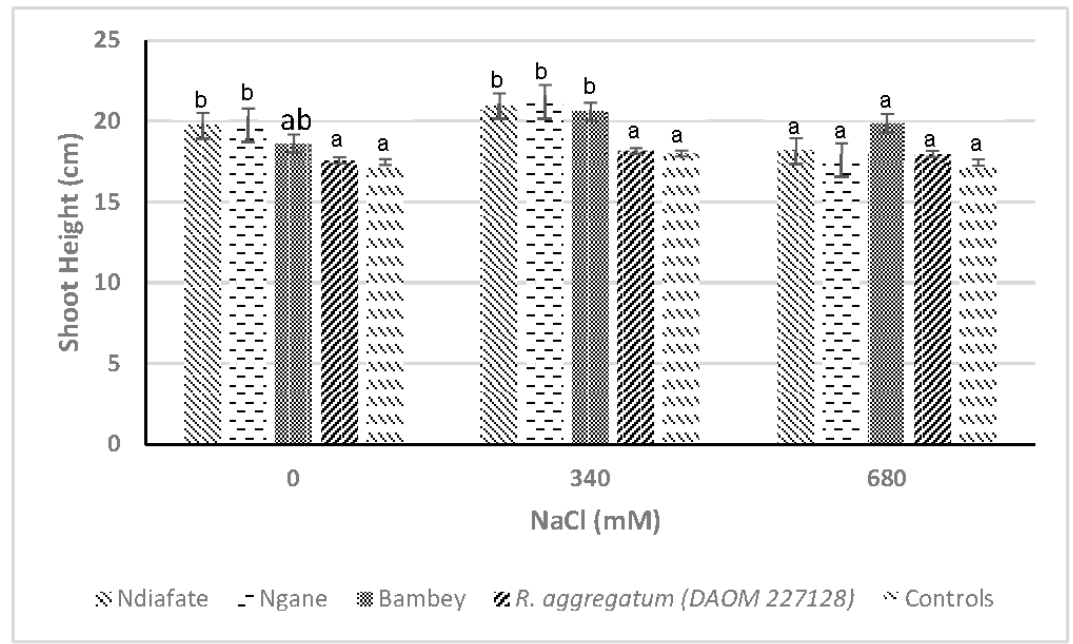
Figure 2. The effect of the AMF isolates × NaCl interaction on the growth of shoot parts of A. seyal seedlings after 30 days of culture. Ndiafate, Ngane, and Bambey correspond to high, moderate, and low salinity zones, respectively, where the AMF were collected. Bars with the same letters for each variable are not significantly different at p < 0.05 (Newman–Keuls test) and error bars represent standard error of the mean ( n =